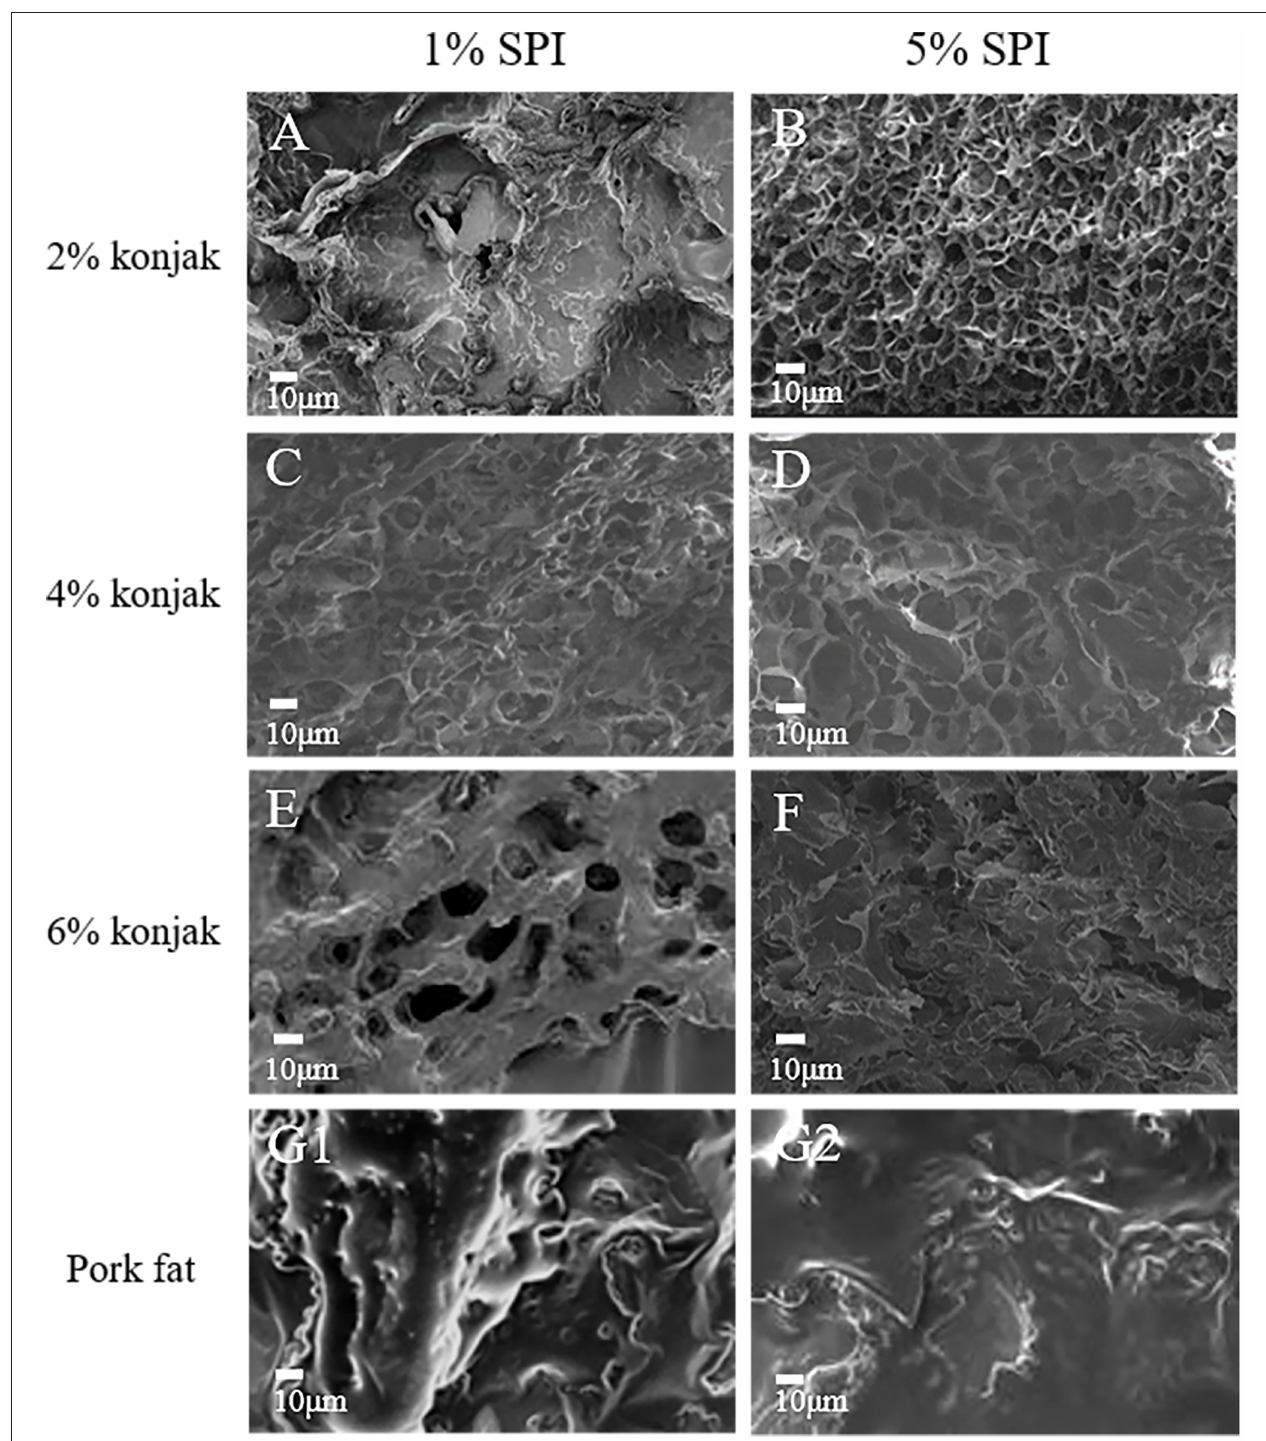
FIGURE 2 | The microstructures of samples with different protein content and konjac content. (A) S1K2; (B) S5K2; (C) S2K4; (D) S5K4; (E) S1K6; (F) S5K6; (G1,G2) : pork fat (cook for 20min).